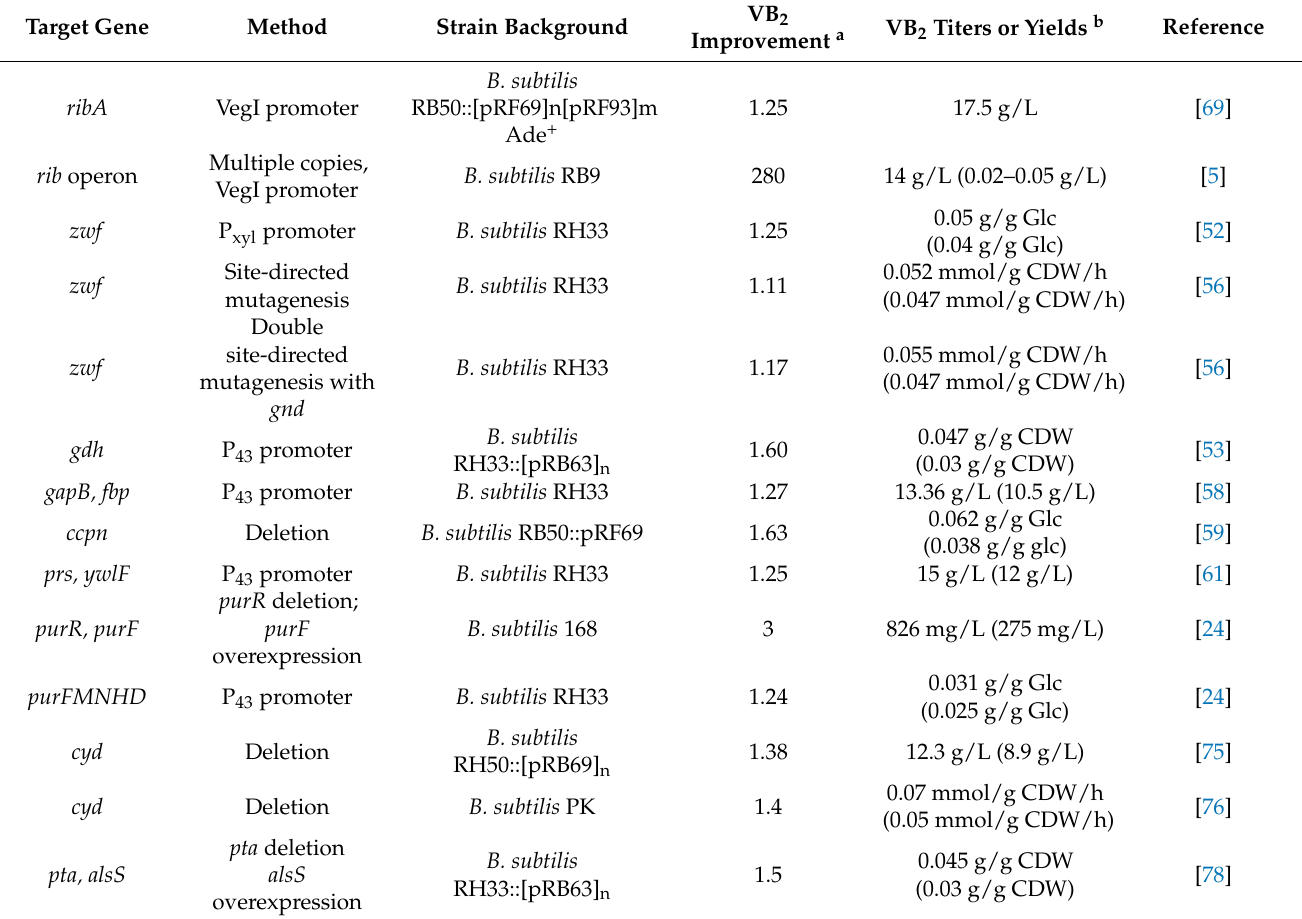
Table 3. Metabolic engineering of Bacillus subtilis for riboflavin